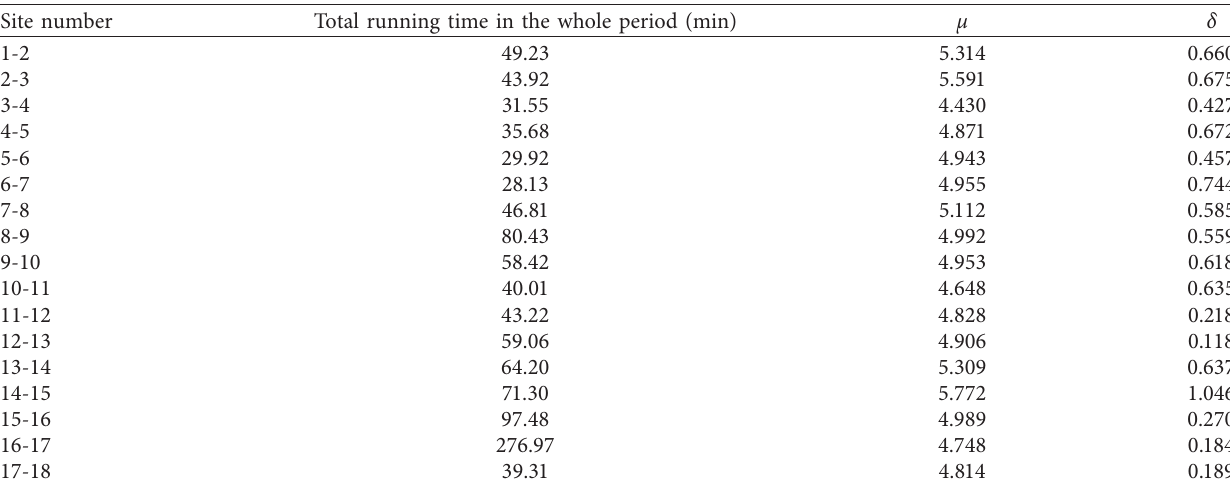
Table 5: Travel time fitting parameters between the stations during the study